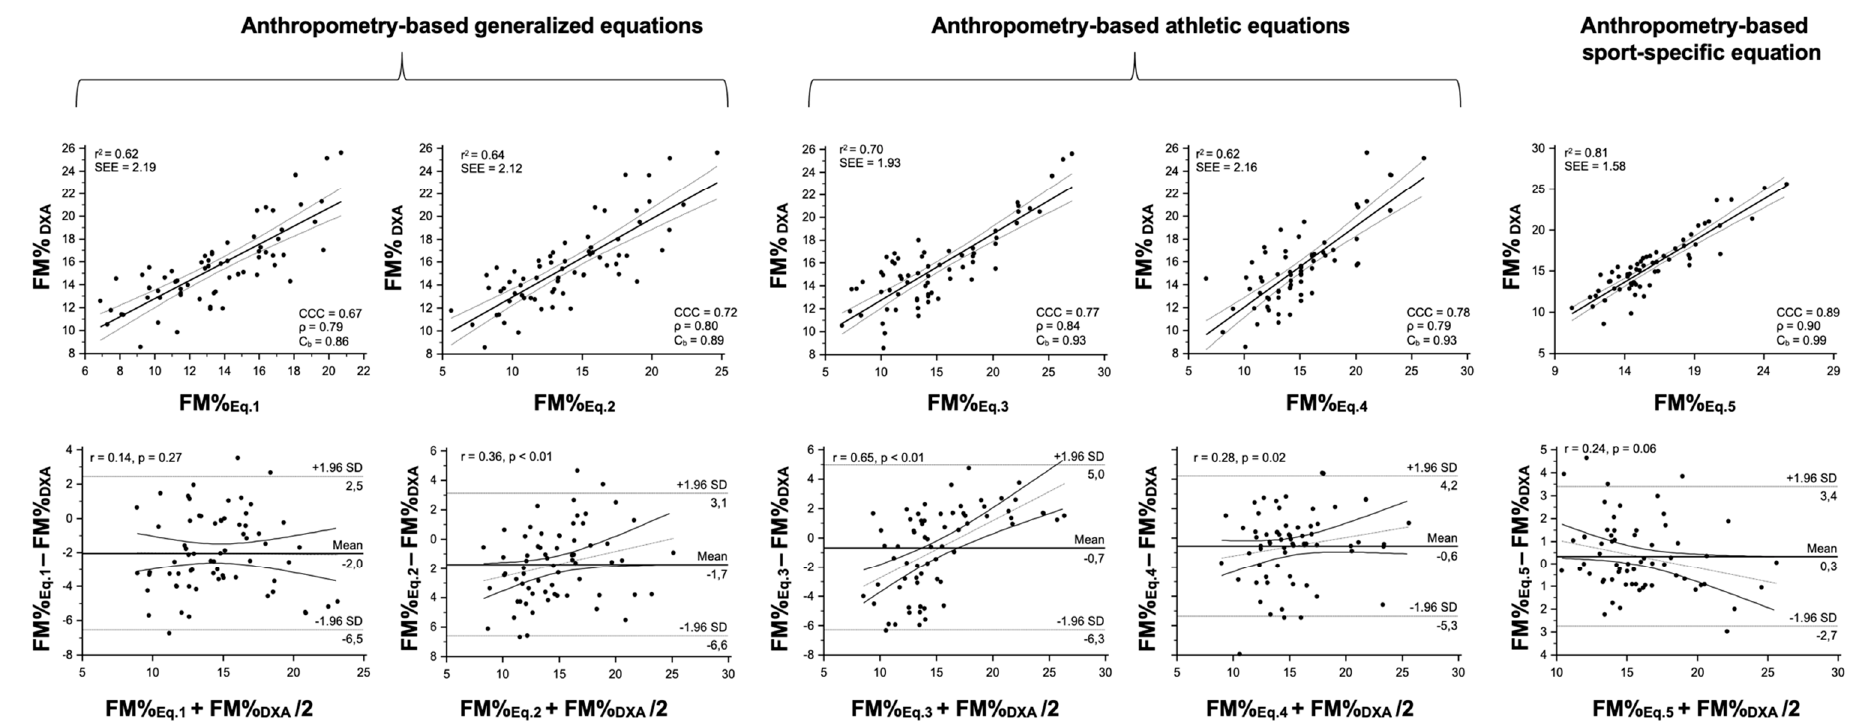
Figure 3. Results from regression, concordance, and agreement analyses between the percentage of fat mass (FM%) estimated from the selected anthropometry-based predictive equations and the reference method (DXA) in the futsal players. In the upper panel, the scatterplots show the relationship between the estimated and the reference FM% and the Lin’s concordance correlation coefficient (CCC), including precision ( ρ ) and accuracy (C b ) indexes. In the lower panel, the results of the Bland–Altman analyses are shown. Eq. 1 = Durnin and Womersley [23]; Eq. 2 = Lean et al. [24]; Eq. 3 = Evans et al. [27]; Eq. 4; Witers et al. [28]; Eq. 5 = Giro et al. [30].